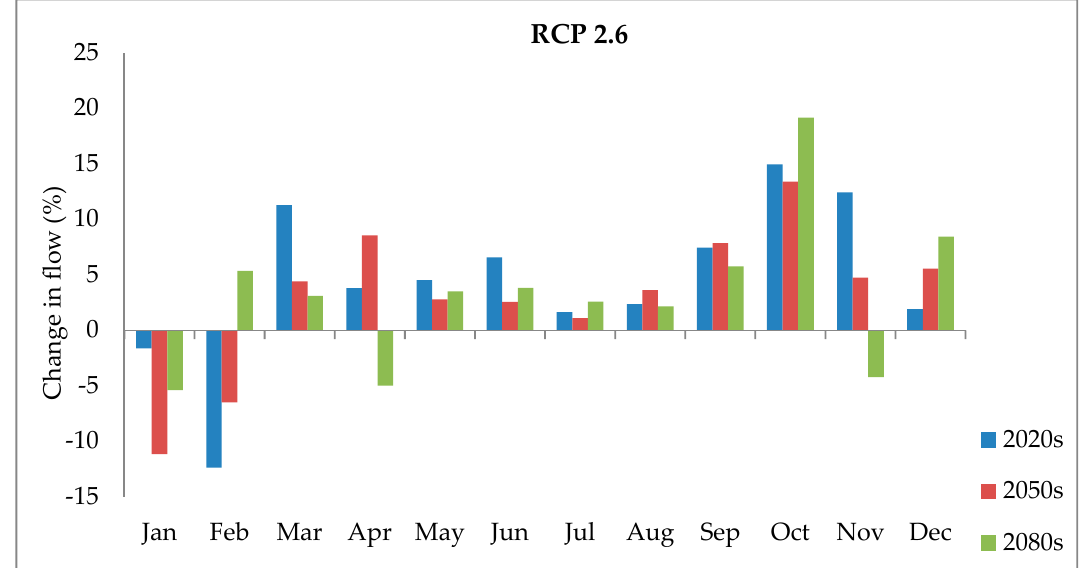
Figure 14. Change in stream flow under RCP 2.6 scenario compared to the baseline period (1961– 1990).